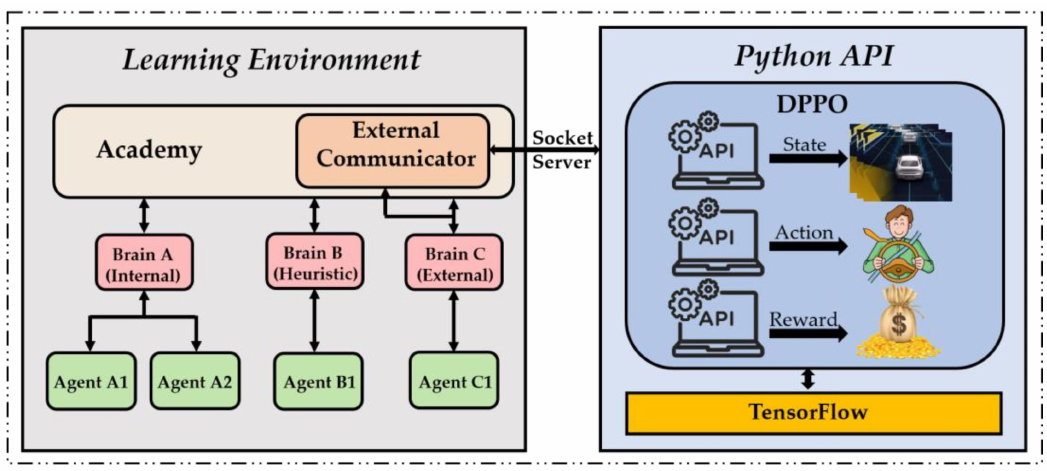
Figure 4. The overall architecture of the simulation